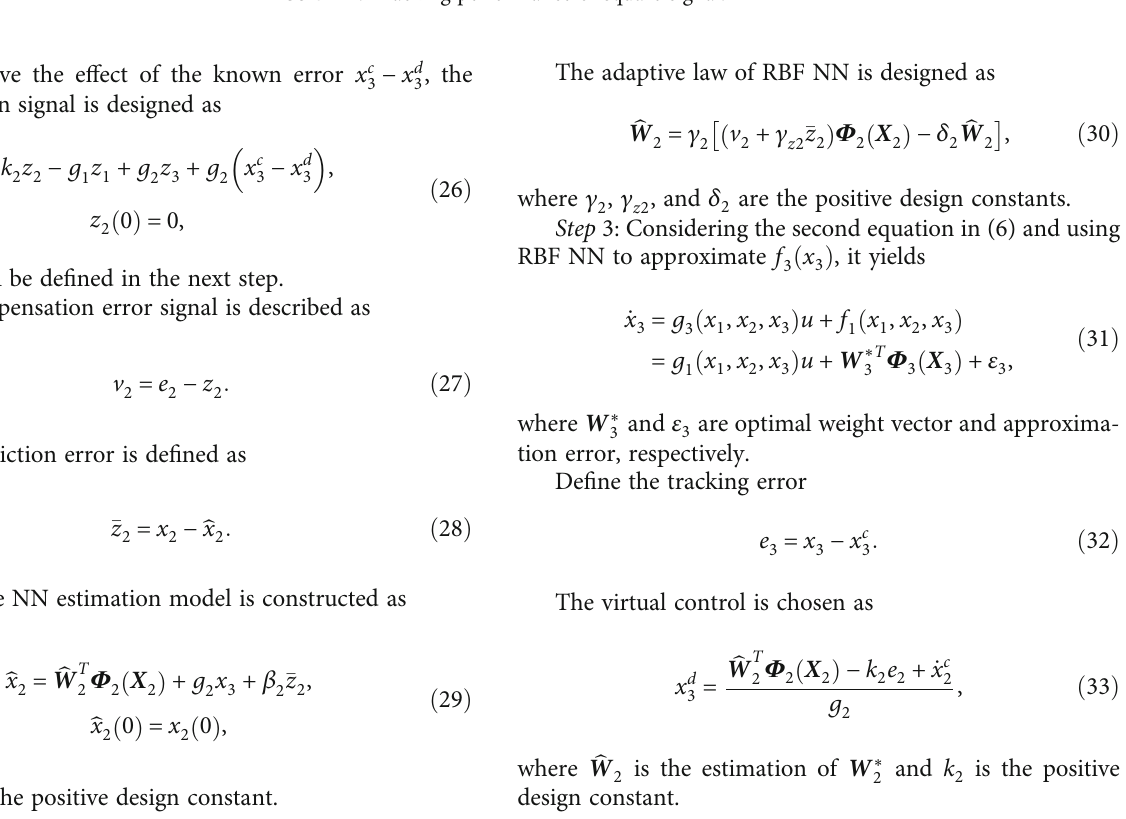
Figure 11: Tracking performance of square